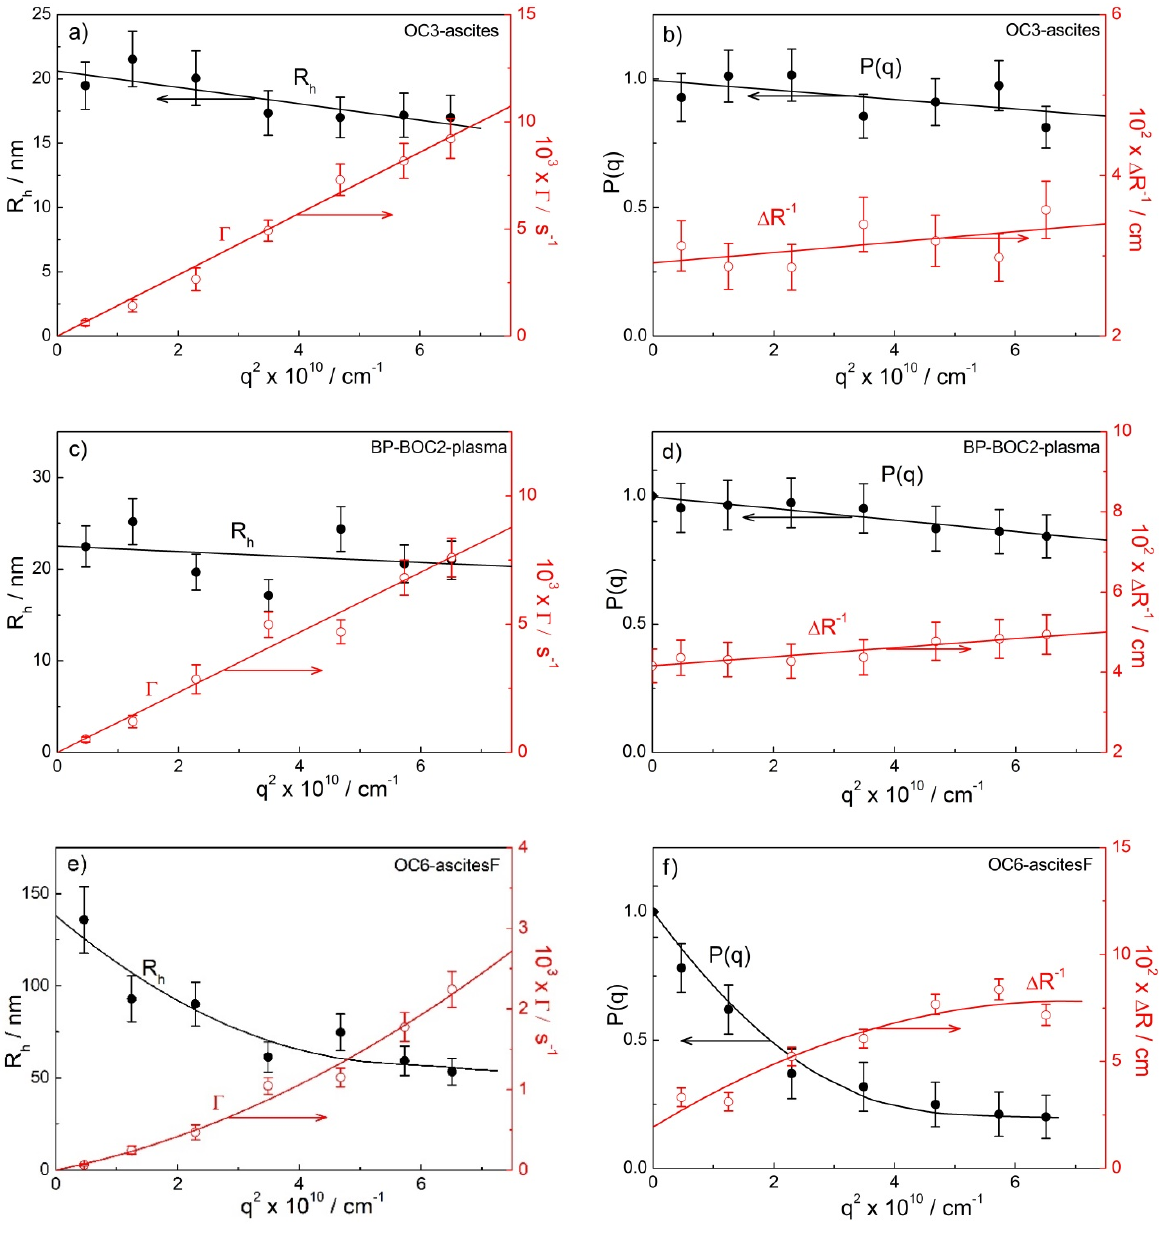
Figure 3. ( a , c , e ) Hydrodynamic radii ( R h ; filled black circles) and decay rates ( Γ ; empty red circles) and ( b , d , f ) form factor ( P ( q )) and the reciprocal of the excess Rayleigh ratio ( ∆ R − 1 ) as a function of the square of the scattering vector ( q 2 ) for small ENPs (peak 2) in the ascites of ovarian cancer (OC) patient OC3 ( a , b ) and the plasma of patient with benign ovarian cyst (BP-BOC2) ( c , d ), and for large ENPs (peak 3) in the filtered ascites (ascitesF) of patient OC6 ( e , f ). In the calculation of R h values for large ENPs (Figure 3e), the viscosity value η o ≈ 1.2 mPa s − 1 was considered (see Section 4). The obtained R g values are collected in Tables 2 (all OC patients), 3 (all BP-BOC pa-